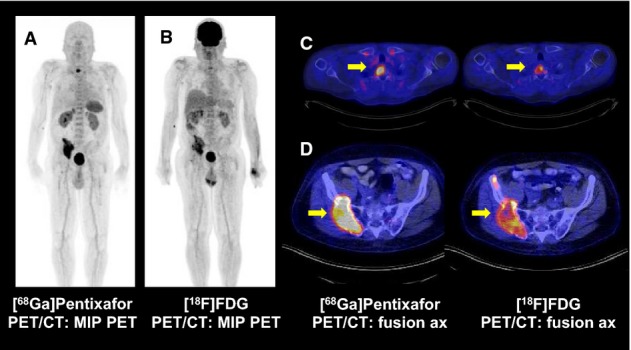
[68Ga]Pentixafor PET/CT and [18F]FDG PET/CT
A–D Maximum intensity projections (MIP) of [68Ga]Pentixafor (A) and [18F]FDG PET/CT (B) of a 68-year-old male with histologically proven multiple myeloma indicating the better lesion-to-background contrast for [68Ga]Pentixafor in the corresponding myeloma manifestations. Trans-axial views of the upper thorax (C) and the pelvis (D) underline the higher uptake values of the bone manifestations (yellow arrows) of [68Ga]Pentixafor compared to [18F]FDG.